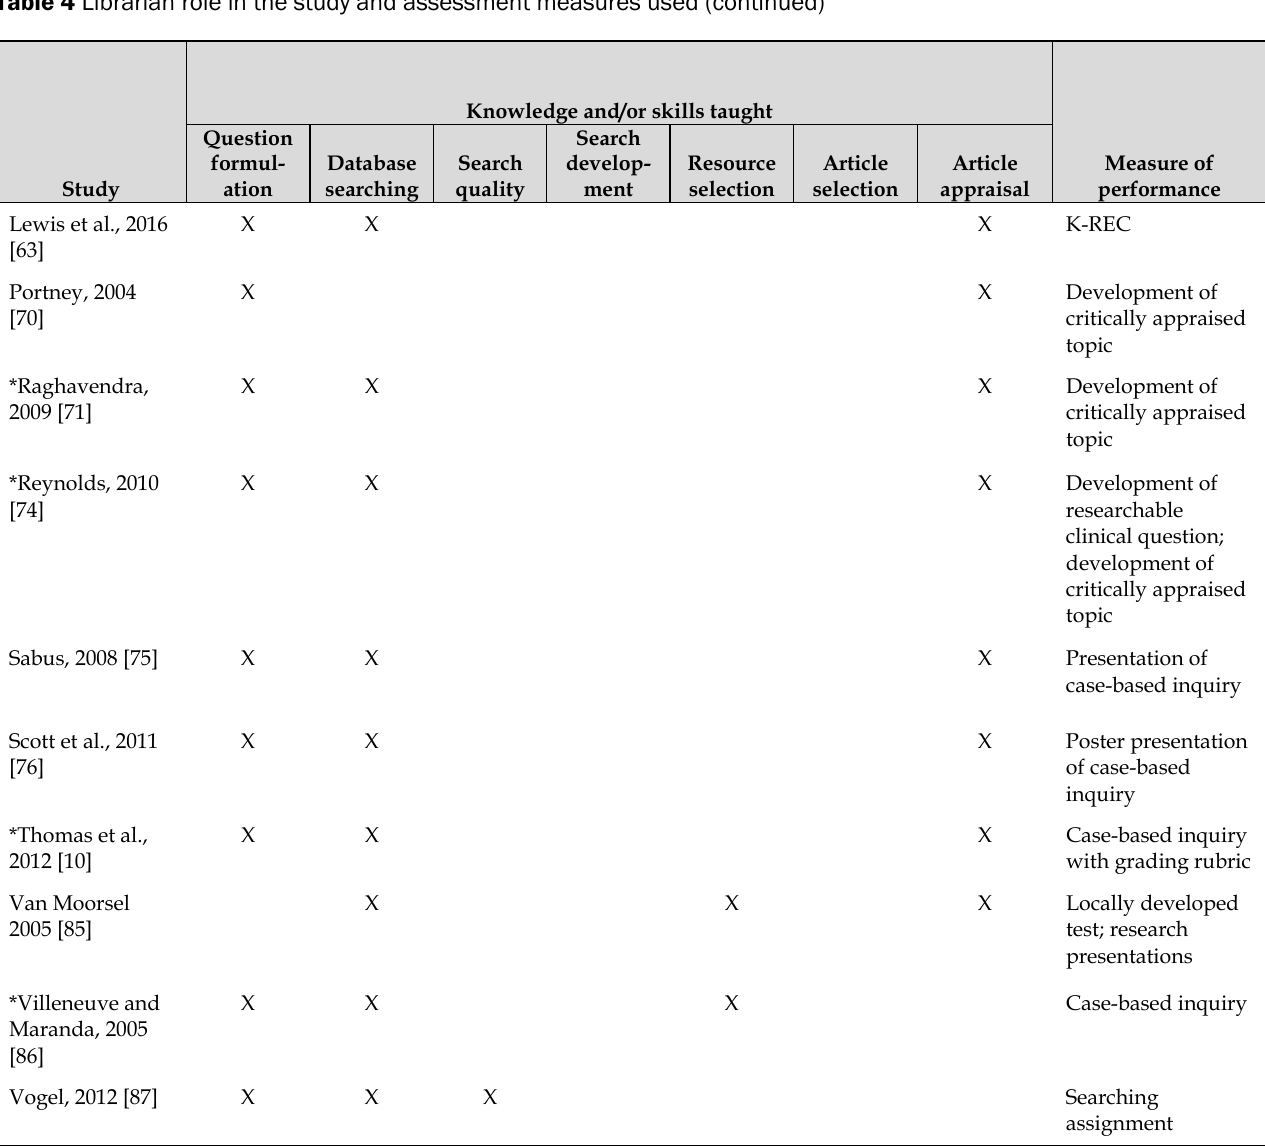
Table 4 Librarian role in the study and assessment measures used